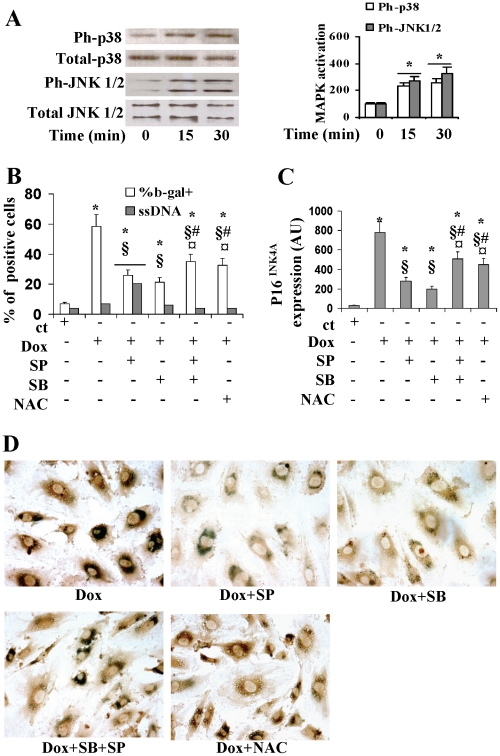
p38 and JNK control the cell response to sub-apototic doses of doxorubicin differently.(A):effects of exposure to 0,25 µM doxorubicin on MAPK activation by western blot using antibodies specific for phosphorilated (Ph) and total p38 and JNK (left panel). Bar graph showing values for ph-MAPK normalizzated to the amount of total enzyme and expressed as the relative increase above control value, which was set at 100 (right panel). (B) and (C): bar-graphs showing the effects of pre-treatment with the JNK inhibitor, SP600125, the p38 inhibitor, SB203580 and NAC on the percentage of SA-b-gal and ssDNA positive cells (panel B) and p16INK4A protein levels (panel C). (D): merge of SA-b-gal staining (blue) and immunocytochemistry for p16INK4A (brown) in cells exposed to doxorubicin and pre-treated with or without SP600125, SB203580, or NAC (magnification, ×400). ct, control; Dox, 0.25 µM doxorubicin. SB, p38 inhibitor; SP, JNK inhibitor. *p<0.05 vs ct; § p<0.05 vs Dox.; ¤ p<0.05 vs. SP+Dox; # p<0.05 vs. SB+Dox.